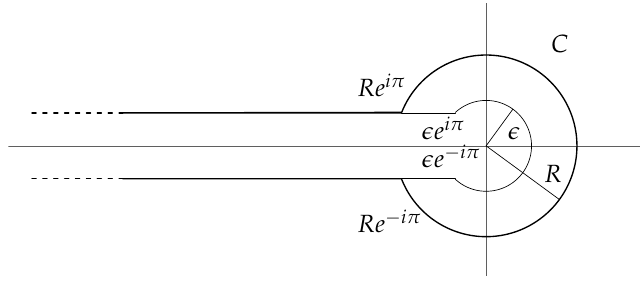
Figure 2. Representation of the contour C